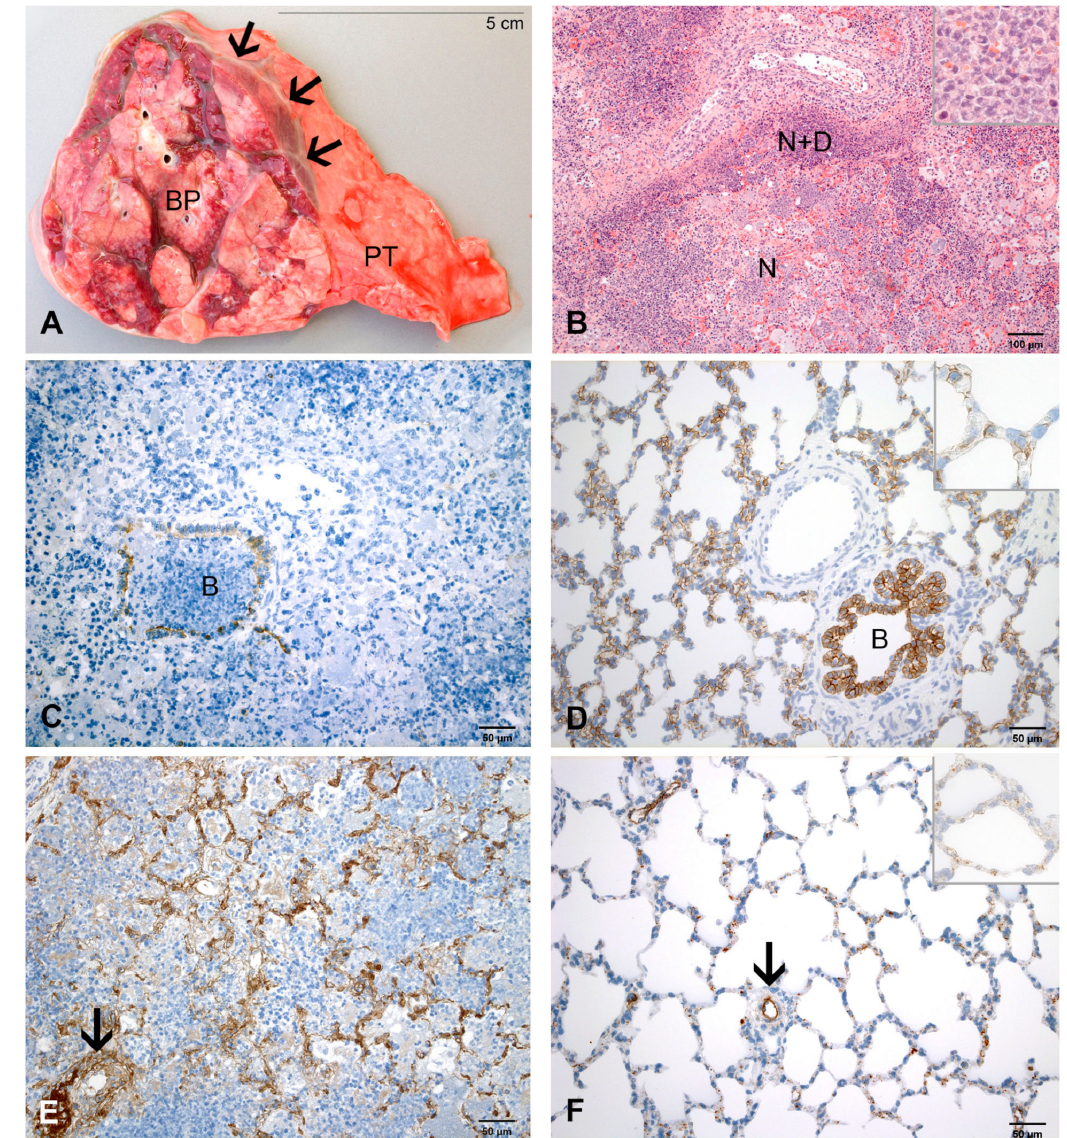
Figure 4. Pulmonary lesions at 4 dpi. ( A ) Section through a basal lobe. The lobular lesion (BP) bulges above the surface of the surrounding pulmonary tissue (PT). The cut surface is drey and marbled grey-red. Interlobular septae and subpleural space are dilated by fibrinous exudate (arrows). ( B ) A large area of necrosis (N) is demarcated by neutrophils and cellular detritus (N + D). Inset: higher magnification of necrosis. HE-stain. ( C ) Epithelial cells are labelled only in segments of the bronchiolar wall (B). There is no labelling of epithelial cells in the surrounding alveoli. IHC, cytokeratin. ( D ) Labelling of epithelial cells in a bronchiolus (B) and surrounding alveoli in the healthy lung of a control calf. Inset: higher magnification of AEC1 in alveolar septae. IHC, cytokeratin. ( E ) Accumulation of fibrin in the wall and perivascular space of an arteriole (arrow). Interalveolar capillaries are dilated by fibrin thrombi (brown). IHC, factor VIII. ( F ) Labeling of factor VIII (brown) is restricted to endothelial cells (arteriole as example, arrow) and thrombocytes in the healthy lung of a control calf. Inset: higher magnification capillaries in alveolar septae. IHC, factor